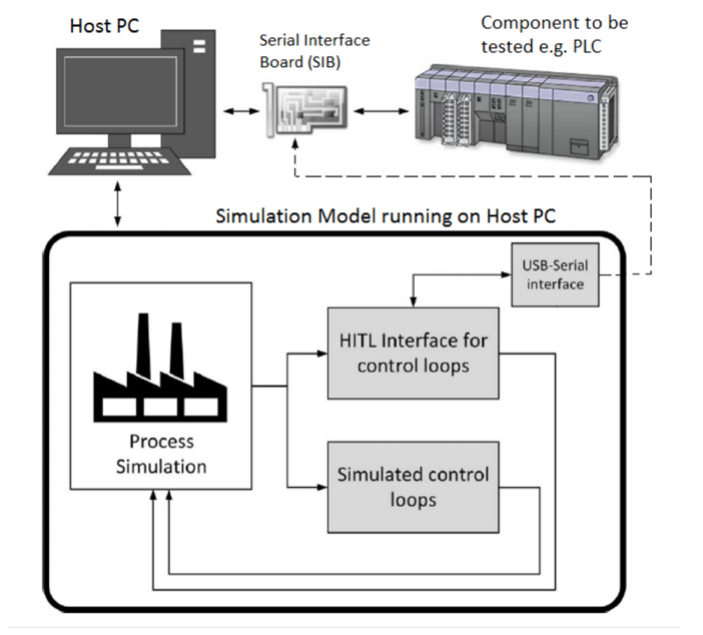
Figure 1. Typical Hardware-In-The Loop (HITL) testbed configuration